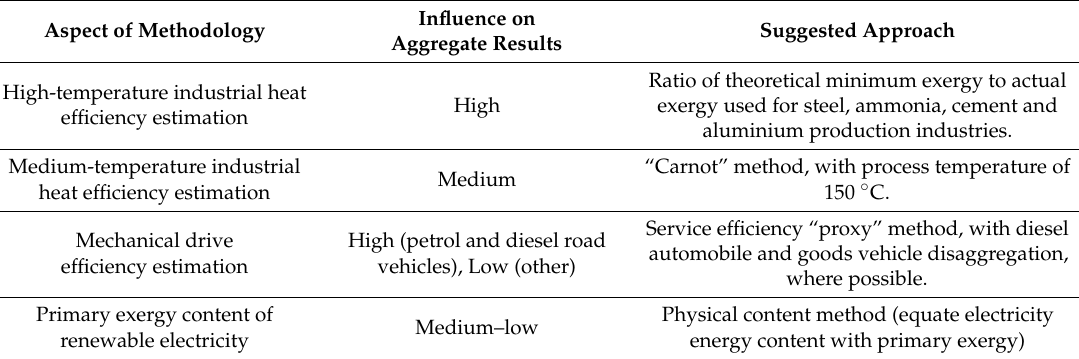
Significance of effect of each aspect of methodology tested, and suggestions for future